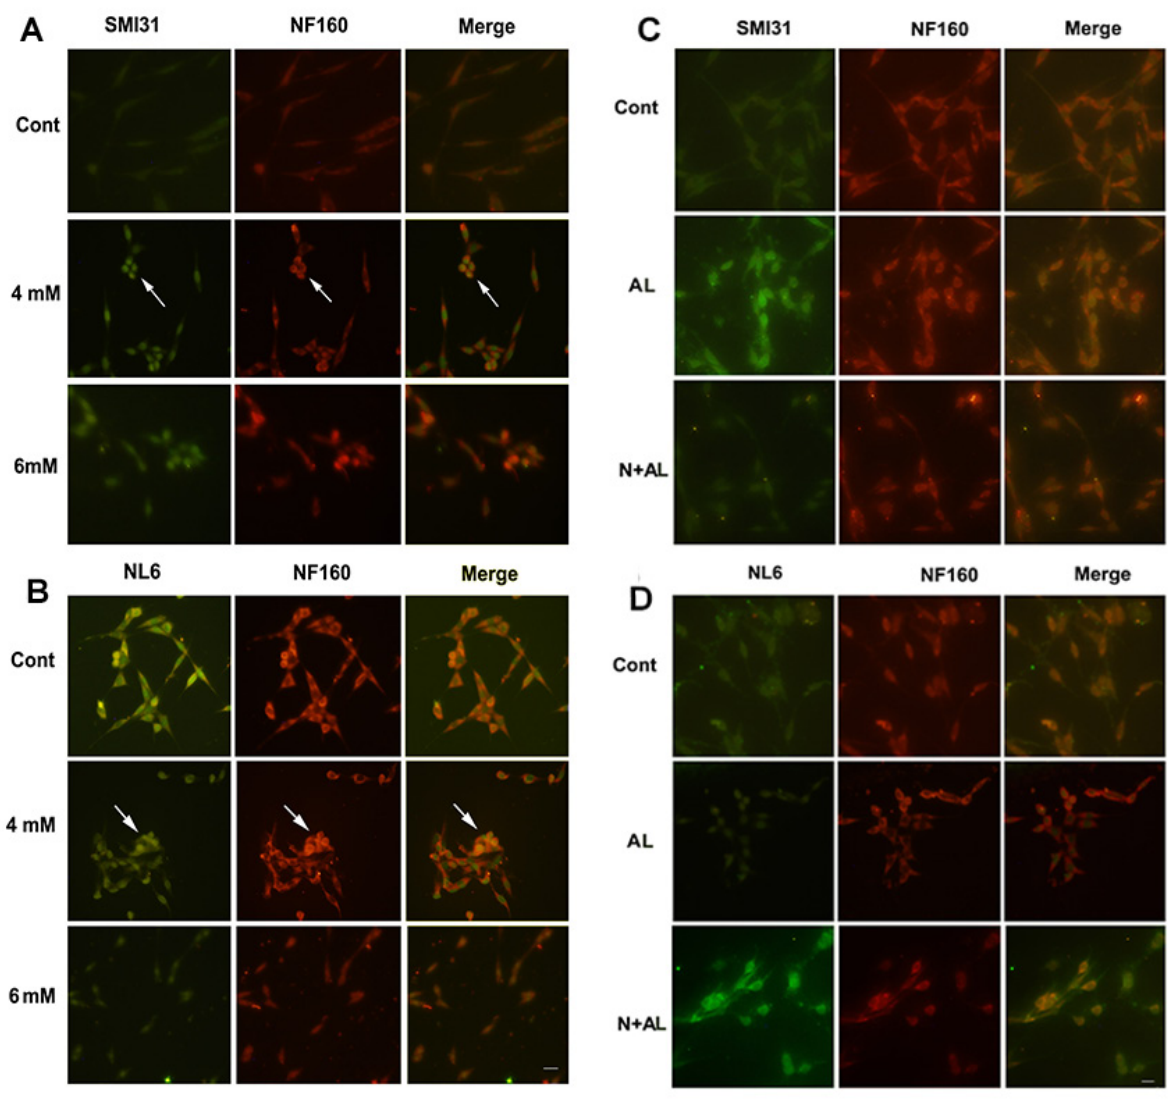
Fig. 3. The localization assay of O-GlcNAc and phosphorylation in SK-N-SH cells. Representative pictures of Immunofluorescence in cells were treated with 4, 6 mM alloxan (A and B) or 20 μM NAG-Ae pretreat- ment (C and D) with antibodies SMI31/NF160 or NL6/NF160, arrow indicated cells to be round with accumulated NF. Scale 100